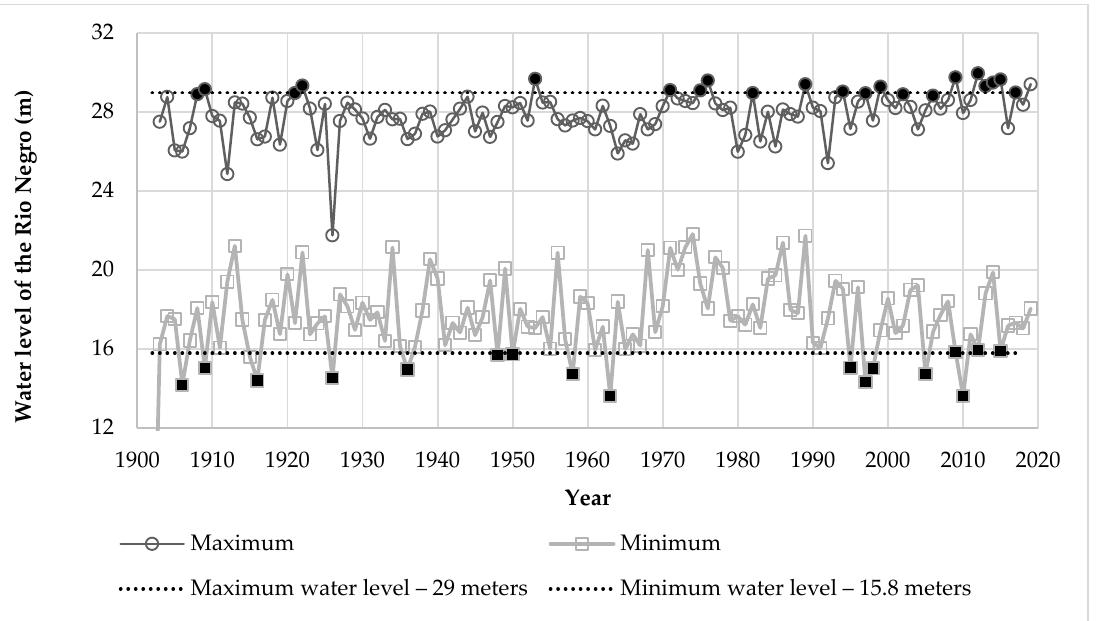
Figure 3. Extreme fluvial events were recorded on the Rio Negro in Manaus from 1903 to 2018. Solid circles represent years of extreme floods and solid squares represent years of extreme ebbs. Data from National Water Agency–ANA [19]. Elaborated by authors.